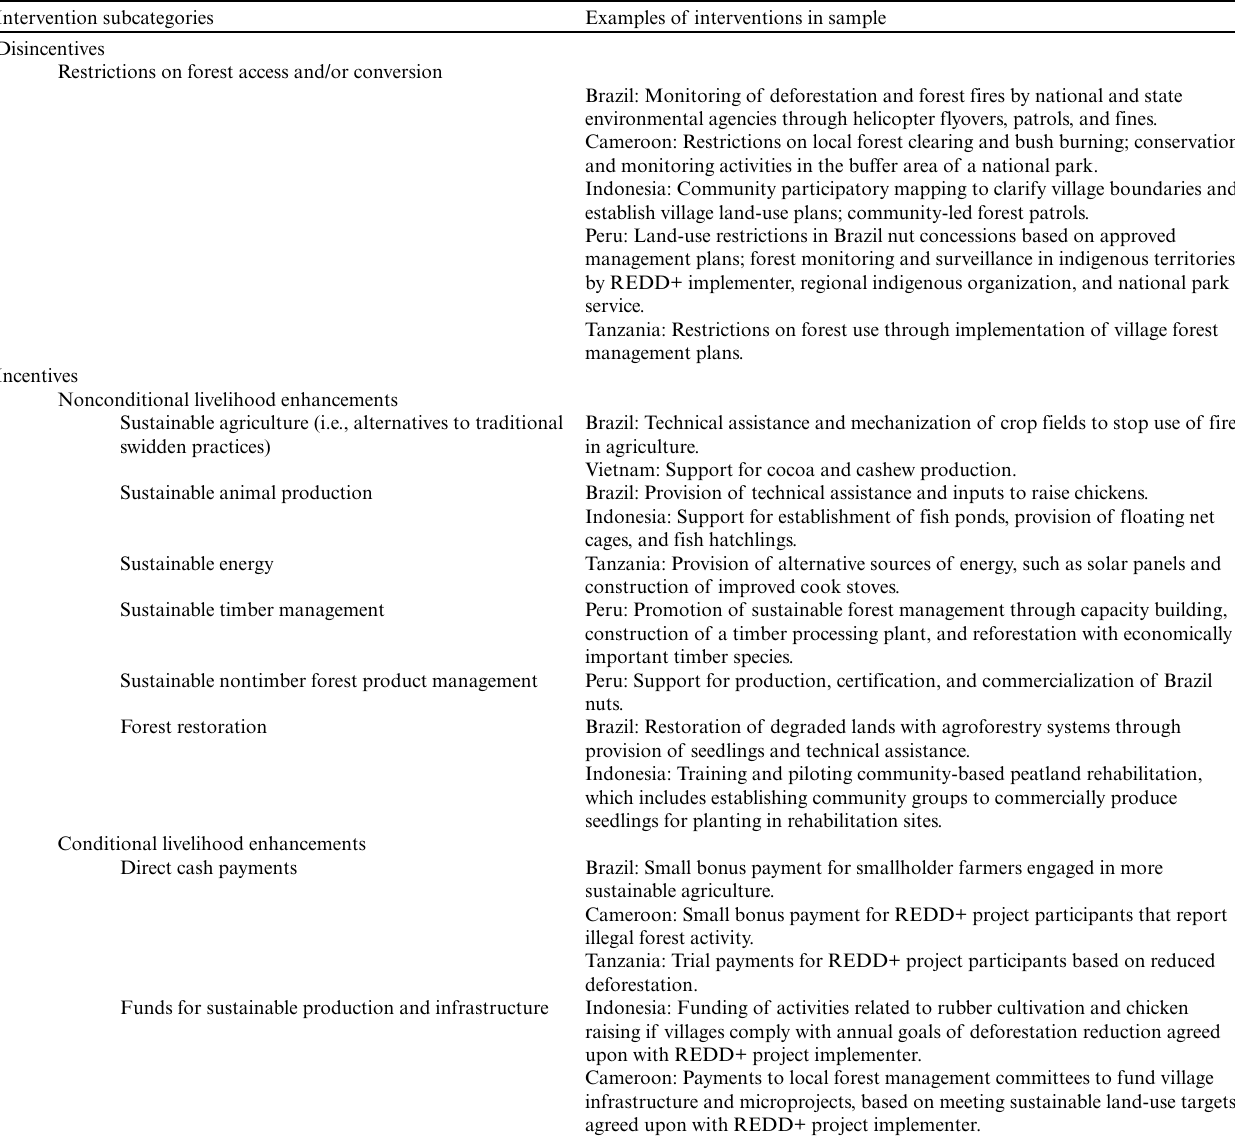
Table 2 . Examples of interventions in disincentive and incentive